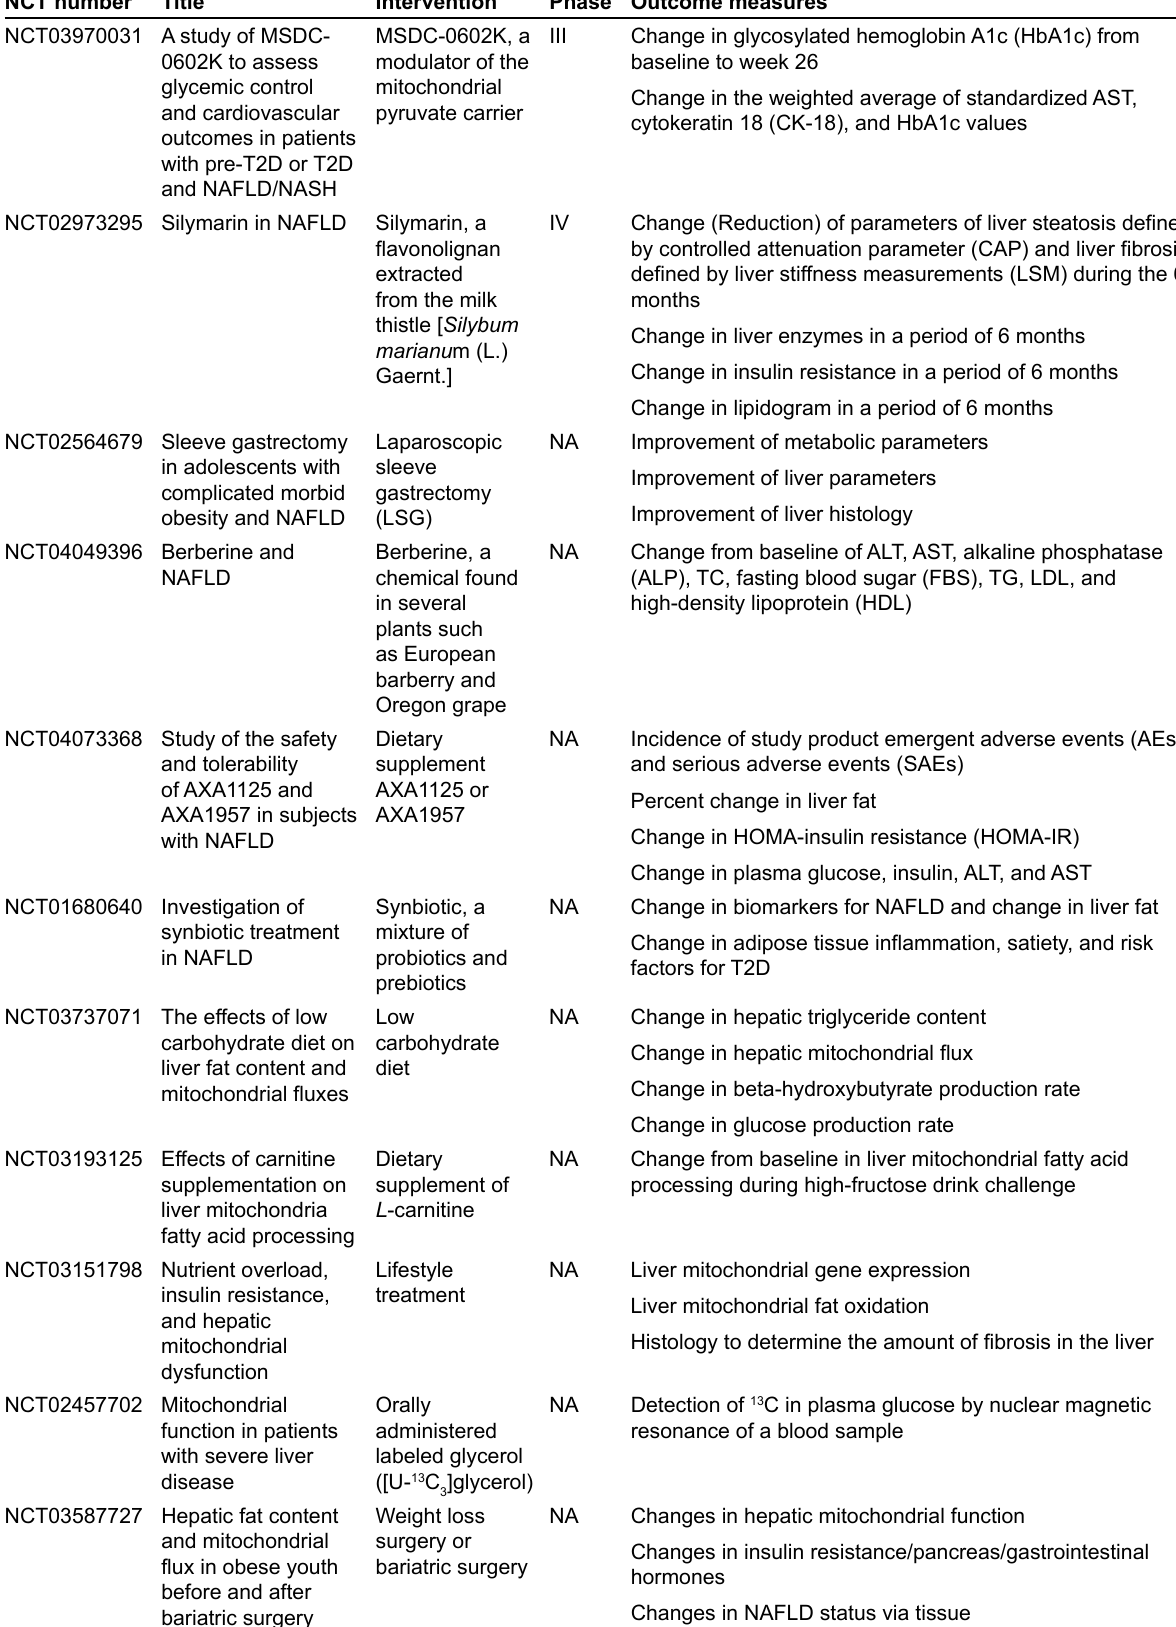
Table 2 . Clinical trials for the intervention of NAFLD ( continued ) NCT